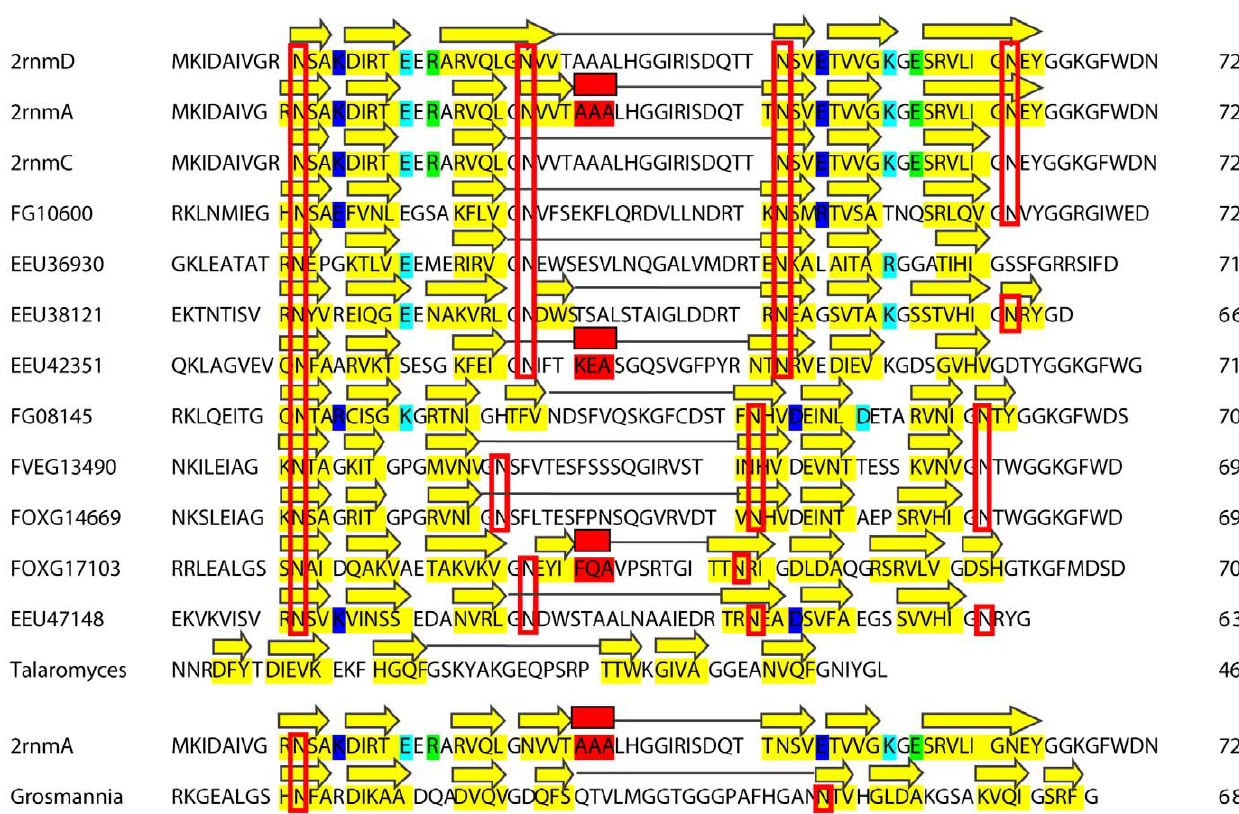
Figure 5. Conserved physicochemical properties of the HET-s structure in homologous solenoid models. The three chains of 2RNM (A, C, D), used as templates in MODELLER, are represented (top). Beta sheet positions (as rendered in PyMOL) are highlighted in yellow (unless colored to represent other physicochemical properties), and helices are highlighted in red. The three salt bridge pairs (K229-E265, E234-K270, R236-E272) of HET- s are highlighted in dark blue, light blue, and light green, respectively. Asparagine ladders are represented in red boxes. The same coloring scheme has been adapted to the 11 generated models against the HET-s solenoid structure. The small s protein from G. clavigera (here, represented as Grosmannia), is also included for comparison against its 2rnm:A template. For all models, gapped positions have been removed for clarity, and the number of amino acids spanning the HET-s PFD are indicated (out of 72 residues). The secondary structure of each model has been placed above each sequence. Beta-strands are represented by yellow arrows and alpha-helices by red boxes. Blank spaces between the yellow arrows represent b arcs within each solenoid rung, and the long connecting loop between the two solenoid rungs in each model has been represented by a grey flat